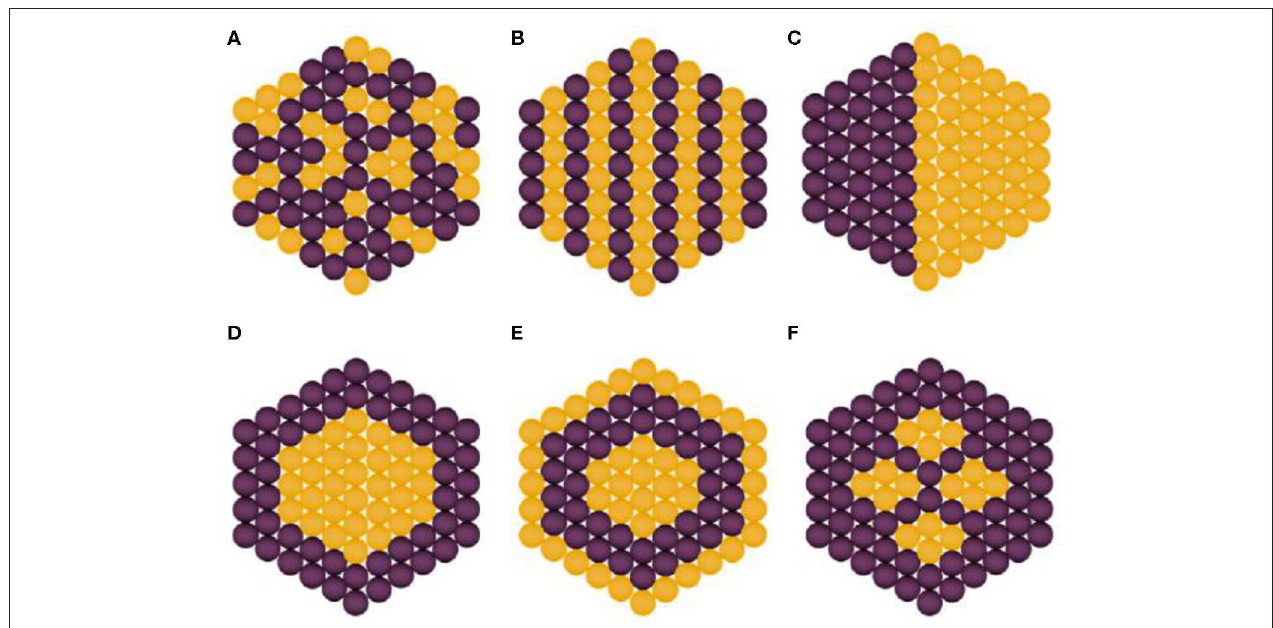
FIGURE 1 | Types of bimetallic nanoparticles: (A) alloyed, (B) intermetallic, (C) subclusters, (D) core–shell, (E) multishell core–shell, and (F) multiple core materials coated by a single shell. Yellow and purple spheres represent two different kinds of metal atoms. Adapted from Srinoi et al. (2018) under the Creative Commons CC BY